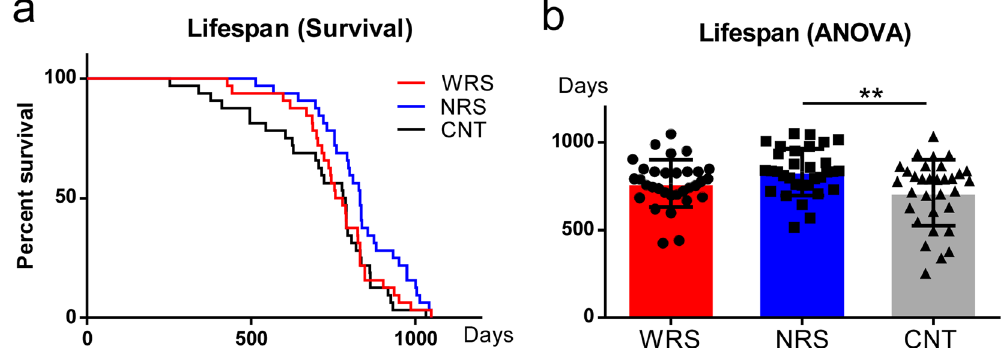
Figure 1. Lifespans for all sound conditions. ( a ) Survival curves and ( b ) average lifespan for all sound conditions: WRS (wide range of sounds), NRS (narrow range of sounds), and CNT (control). Error bars indicate the standard deviation.